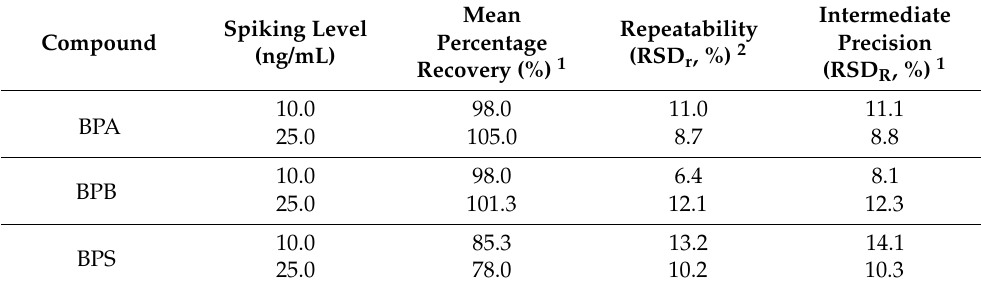
Table 3. Mean percentage recovery, repeatability, and intermediate precision for BPA, BPB and BPS at validation spiking levels.